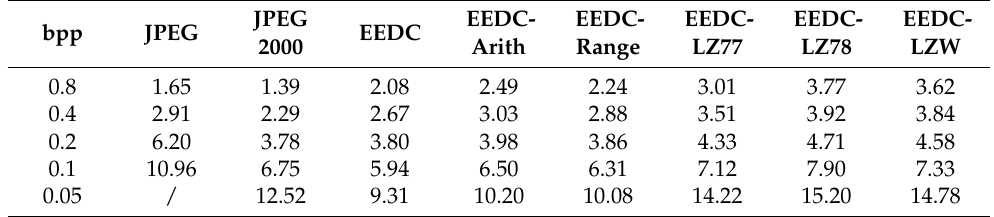
Table 4. Comparison of average absolute error for image horse and all modified compression